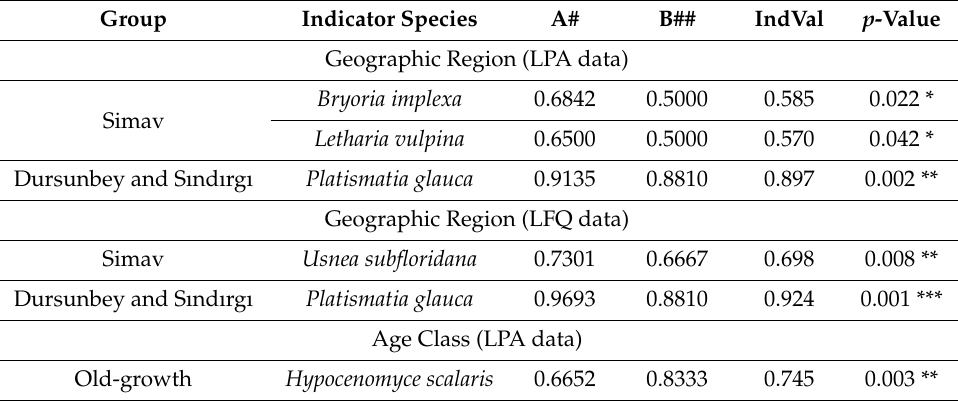
Table 2. Results of the indicator epiphytic lichen species analysis for region and age